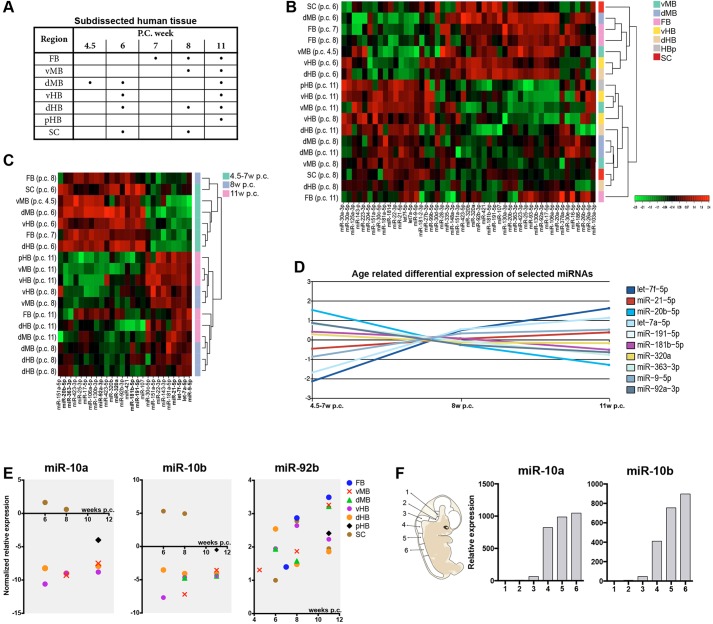
Validation of miRNAs in human foetal brain development. (A) Different dissected regions and ages from human foetal tissue used for the miRNA microarray. Each dot represents n=1. (B) Heat map showing an unbiased clustering analysis of samples using normalized dCq values. The clustering was performed on all samples, and on the top 49 microRNAs with the highest s.d. The colour scale illustrates the relative expression levels of microRNA across all samples. (C) Heat map showing scaled expression of miRNAs displaying large-magnitude changes significantly different between the time points. Colour scale as in B. (D) In order to visualize age-related expression patterns in the top 10 miRNAs from C, their centred average dCq-values were plotted to the three age groups. (E) miR-10a and miR-10b were only detected in the tissue obtained from the pHB and SC. Normalized, centred dCq-values from each sample were plotted by region and age. miR-92b was detected at high levels in all samples. (F) The expression of miR-10a/b was validated in sub-dissected HB to SC from a human foetus 8 weeks p.c. by LNA-RT-qPCR. FB, forebrain; vMB, ventral midbrain; dMB, dorsal midbrain; vHB, ventral hindbrain; dHB, dorsal hindbrain; pHB, posterior hindbrain; SC, spinal cord.